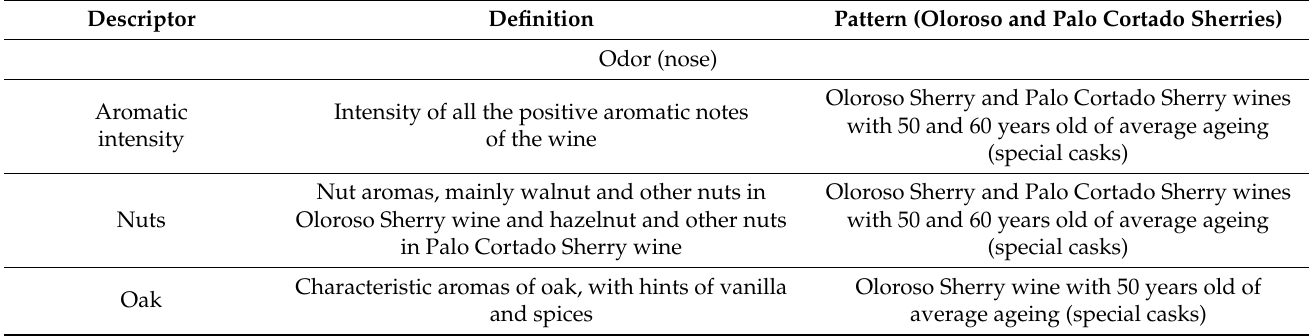
Table 3. Odor and flavor patterns and descriptors used during the tasting